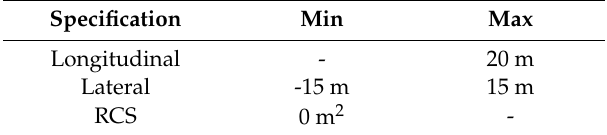
Table 4. Filter setup for the min- and max-filter to improve Figure 8.